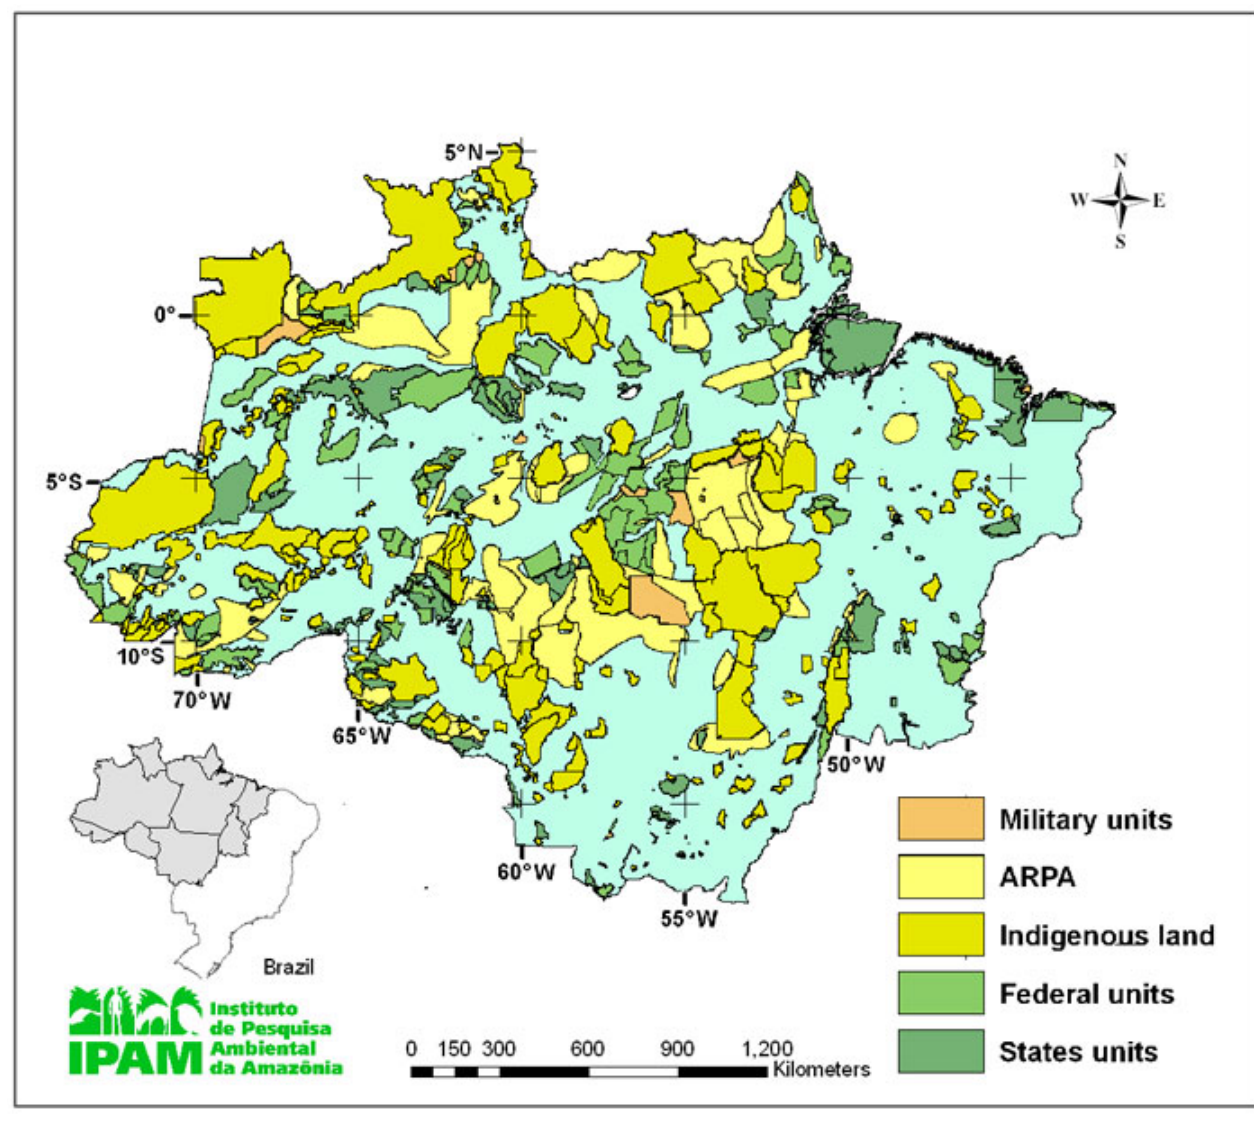
Fig. 1. Current and future planned protected areas (ARPA) in the Brazilian